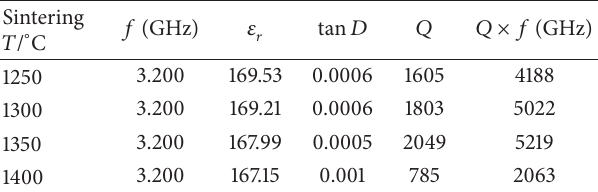
Table 1: Microwave dielectric properties of CaTiO sintering